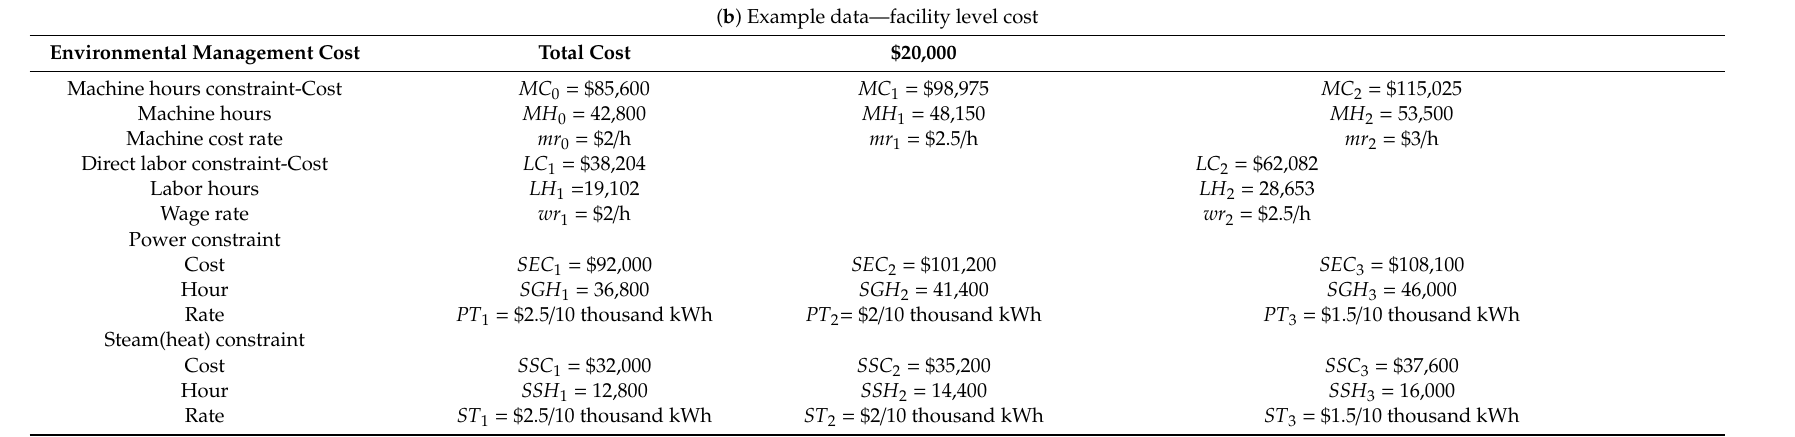
( b ) Example data—facility level